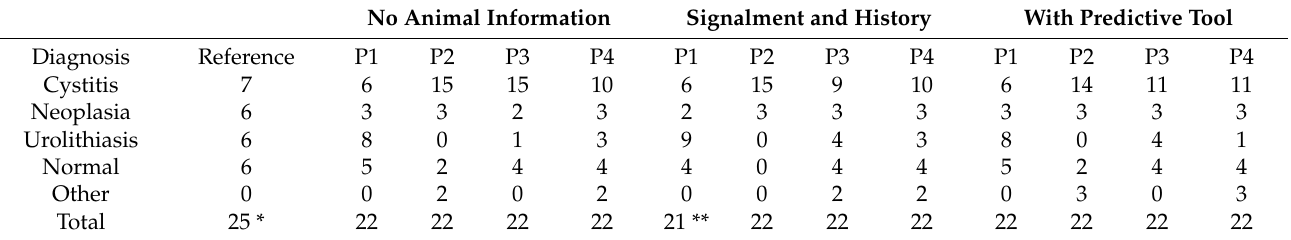
Table 4. Glass slide count data from all study pathologists,